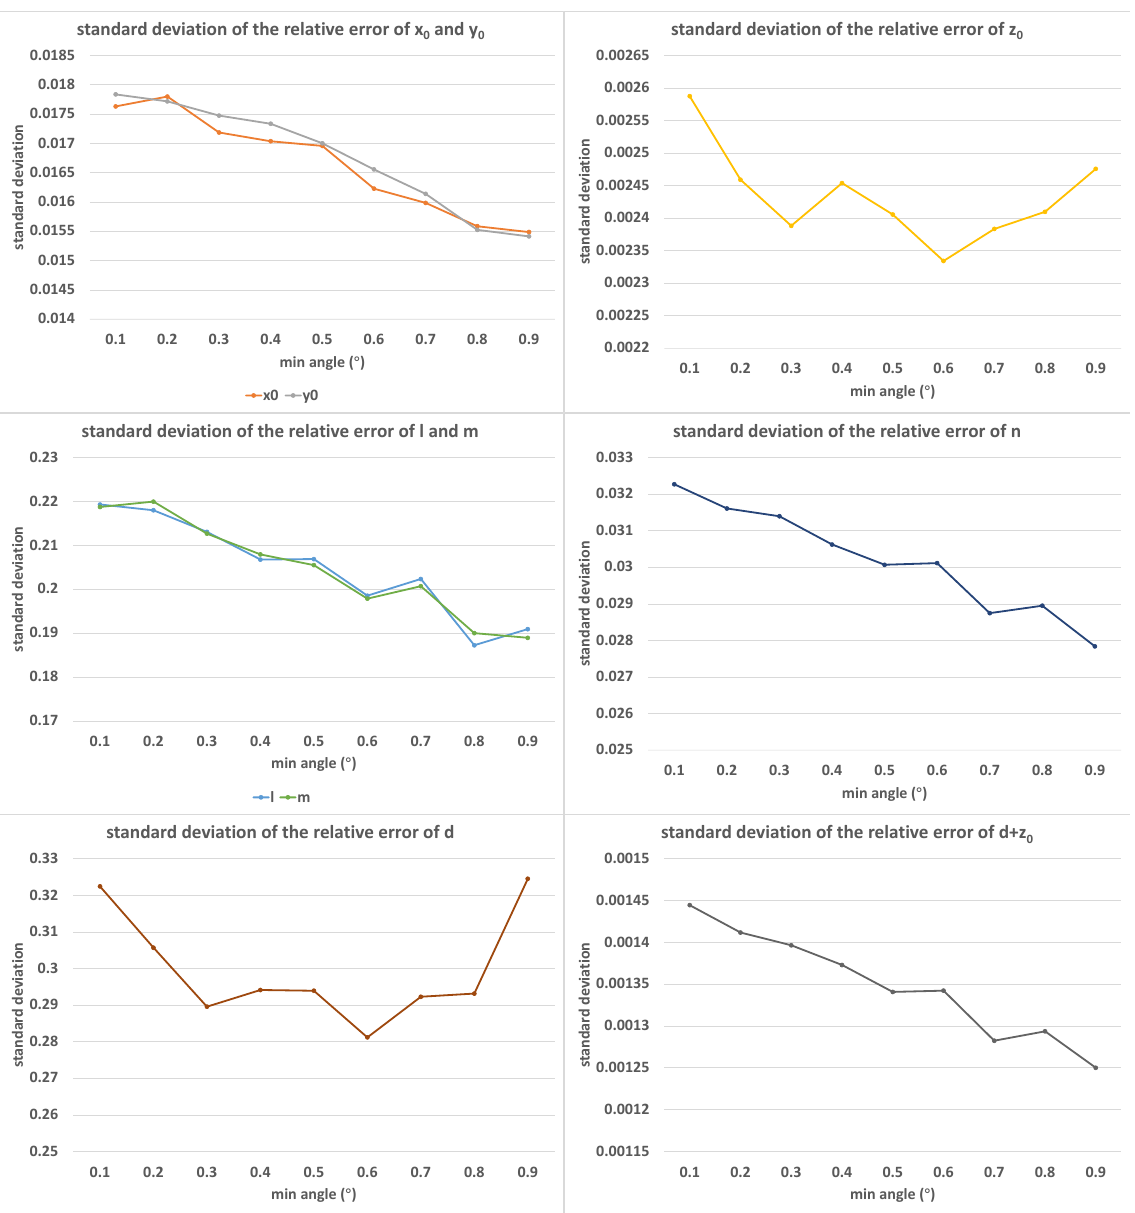
Figure 7. The standard deviations of relative errors of ( x 0 , y 0 , z 0 , l , m , n , d , d + z 0 ) with the increase in β ; the horizontal axis was measured in